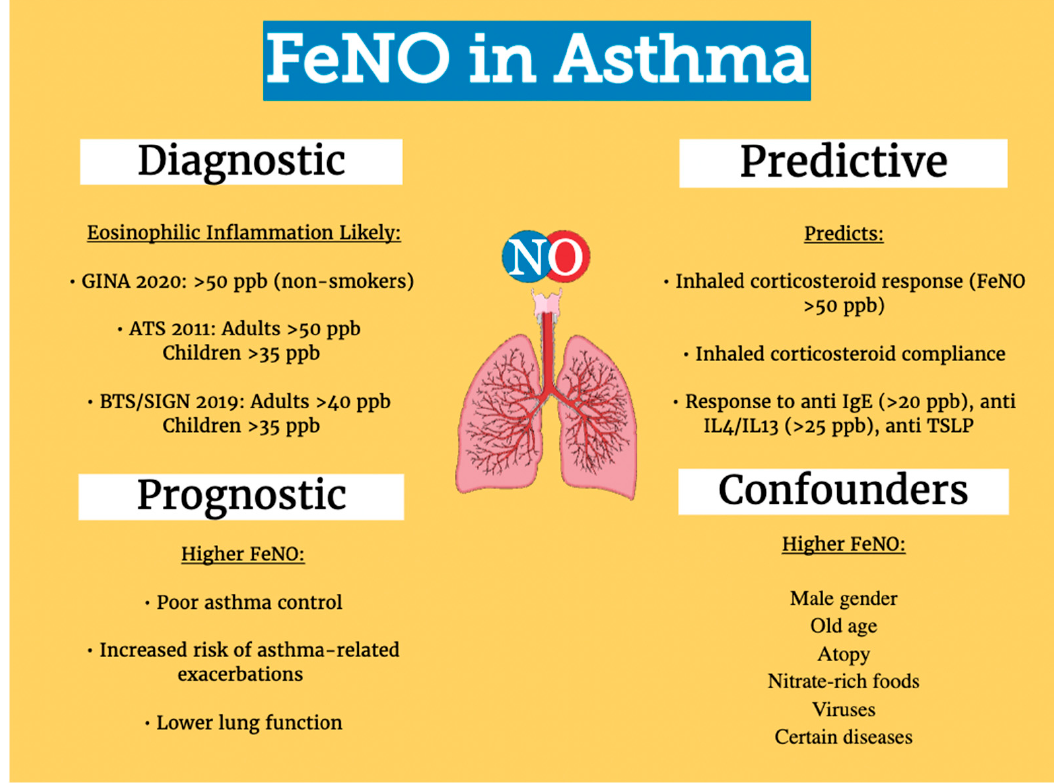
Figure 1. Diagnostic, prognostic, predictive value, and common confounders of FeNO use in asthma.